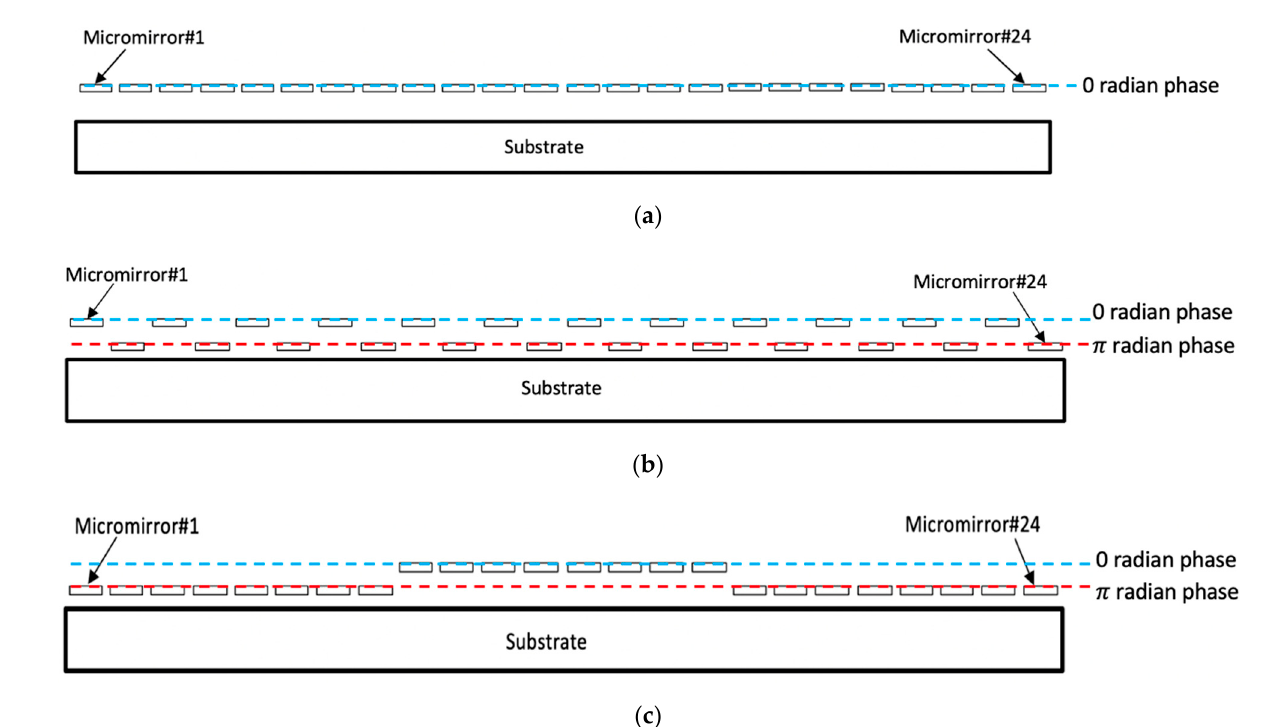
Figure 7. Schematics of various patterns of binary phase shift created by the piston-type OPA device consisting of 24 micromirrors with: ( a ) no phase shift; ( b ) a number of displaced micromirrors per phase period of 1; ( c ) a number of displaced mirrors per phase period of